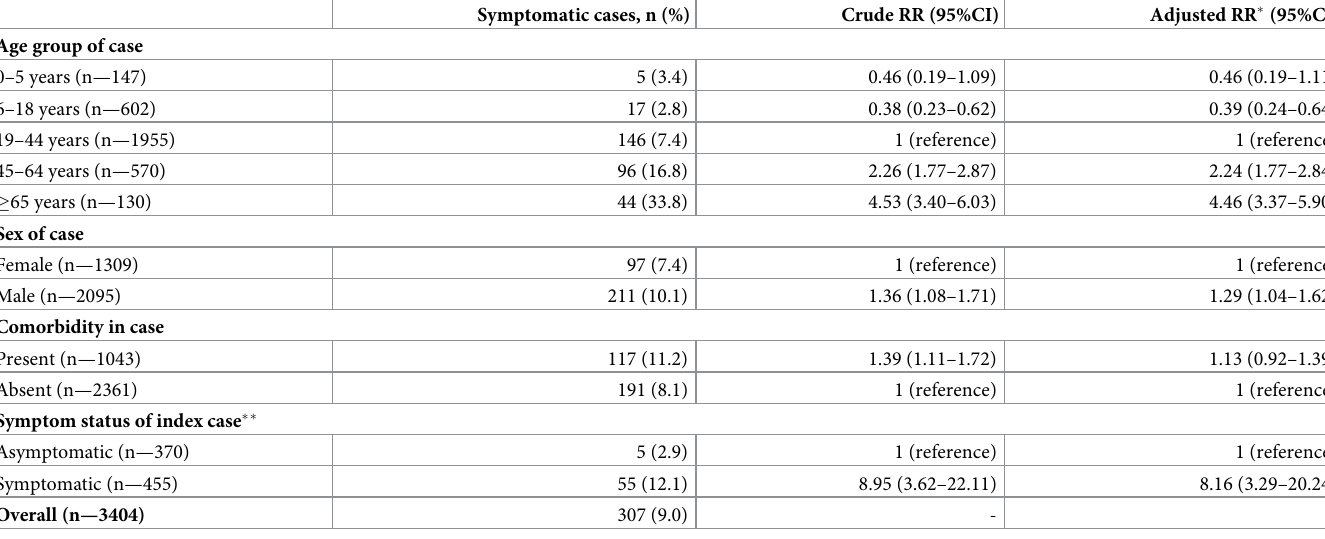
Table 4. Symptomatic proportion and risk of developing symptoms among 3404 COVID-19 cases (Karnataka, India; up to 1 June